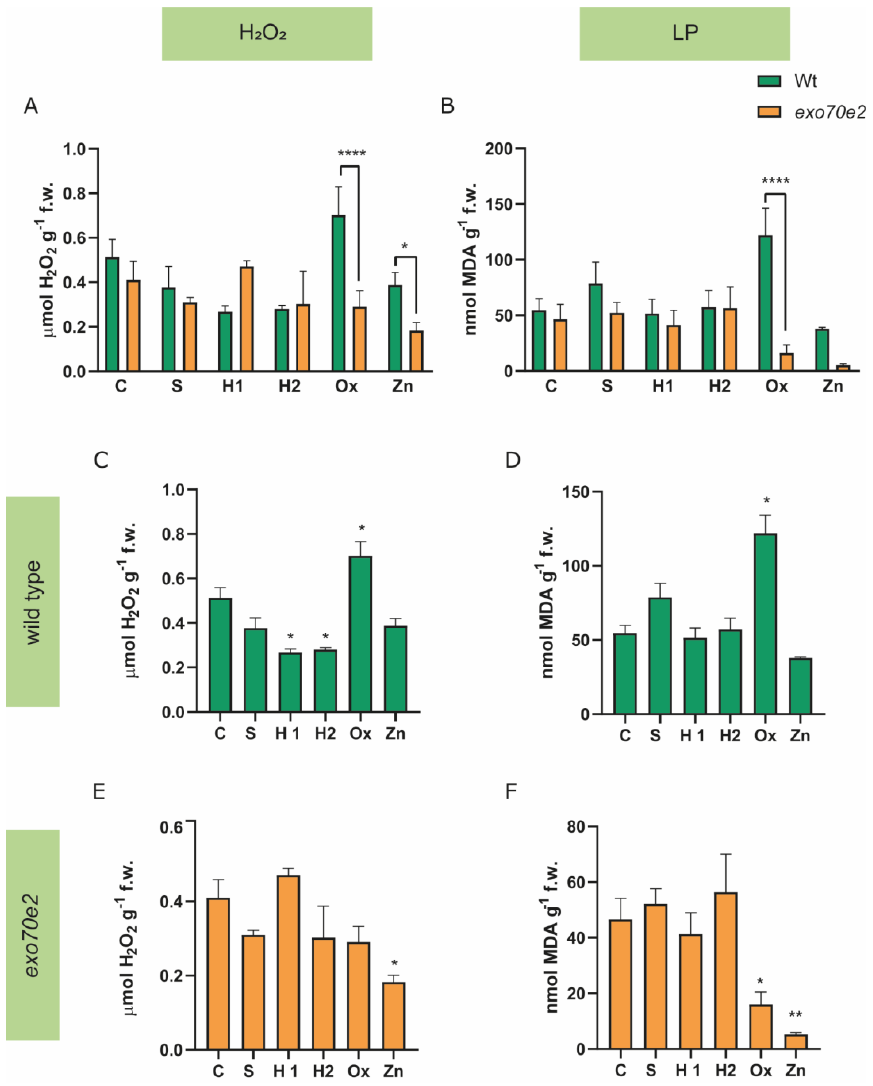
Figure 4. H 2 O 2 and LP activity (expressed as nmol MDA g-1 f.w.) in exo70e2 and wt plants in